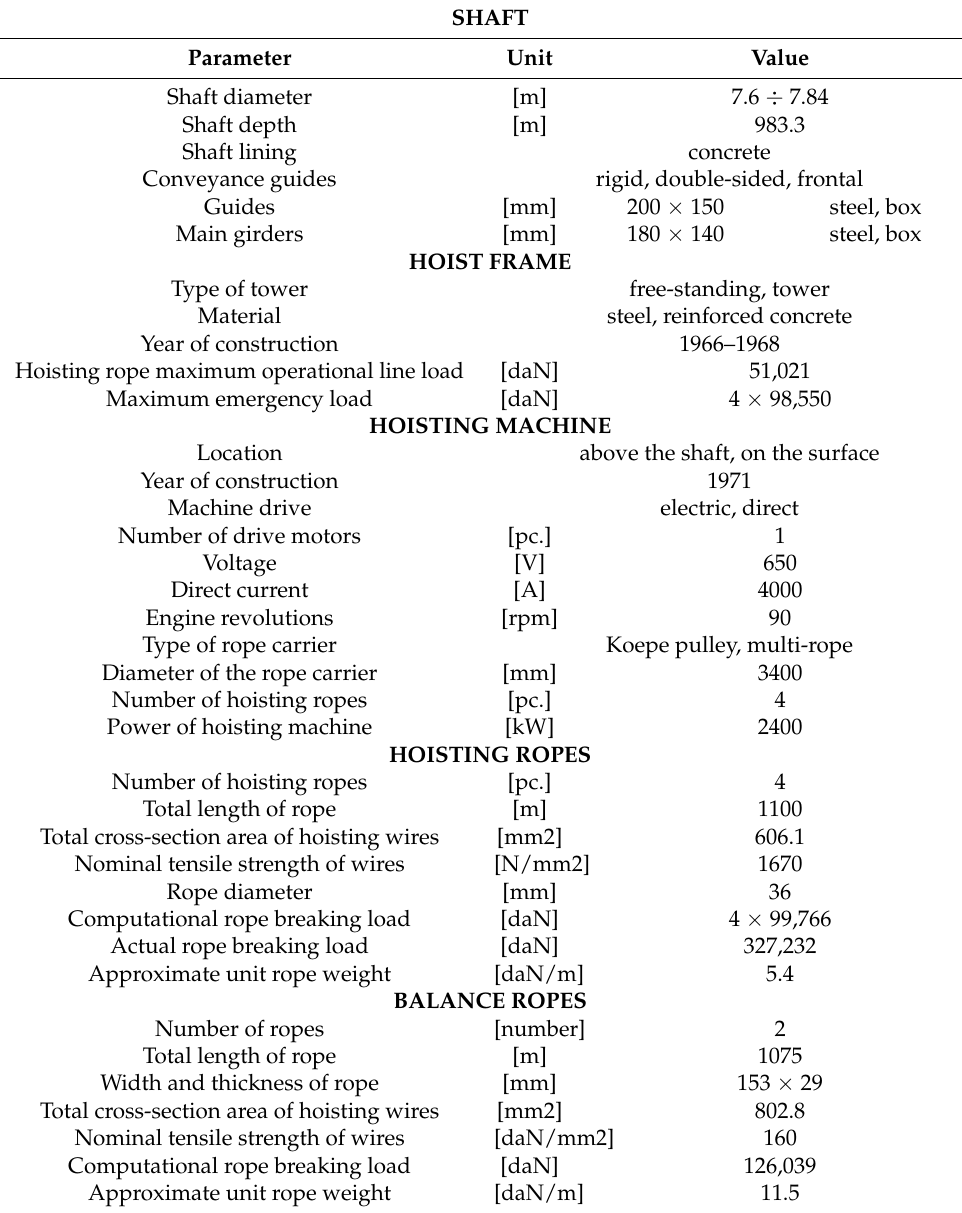
Table 2. The technical specifications of the Budryk